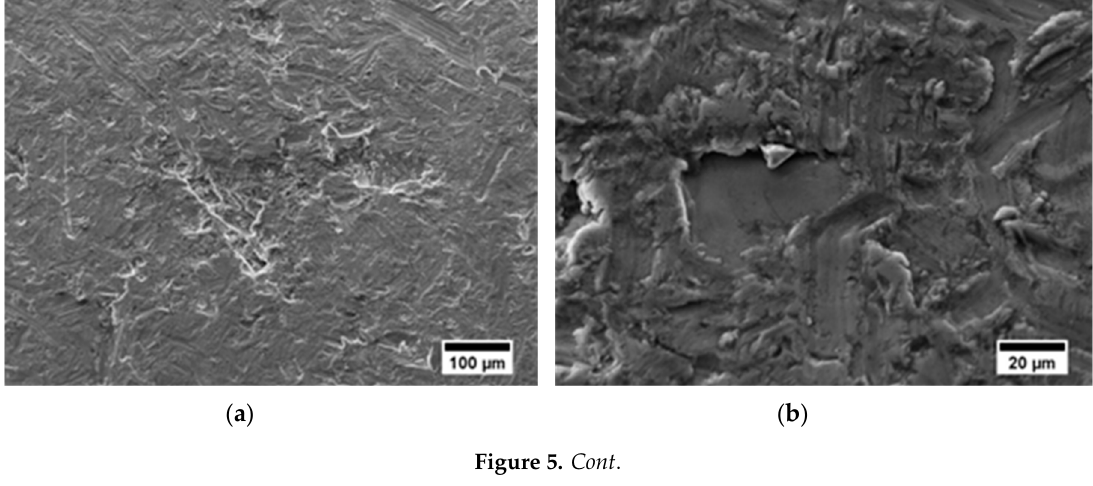
Figure 4. Surface morphology of the sandblasted (SB) specimens. ( a , b ) SEM views of the top surface; ( c , d ) optical micrographs of a cross-sectioned sample showing a view of the surface profile.